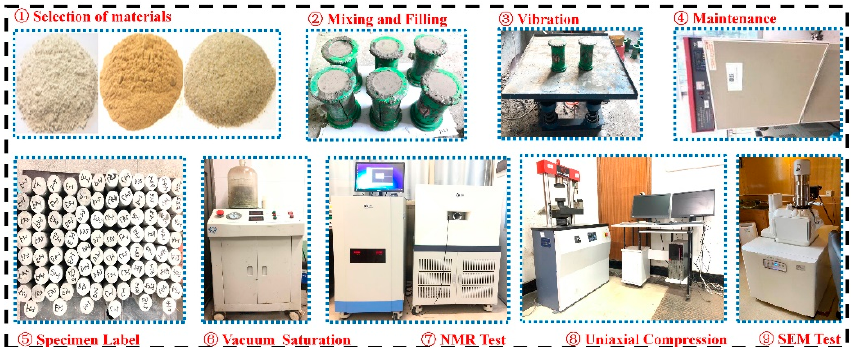
Figure 1. Specimen making and